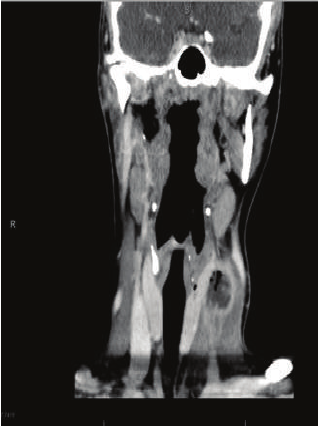
Figure 2: Coronal view CT-scan.